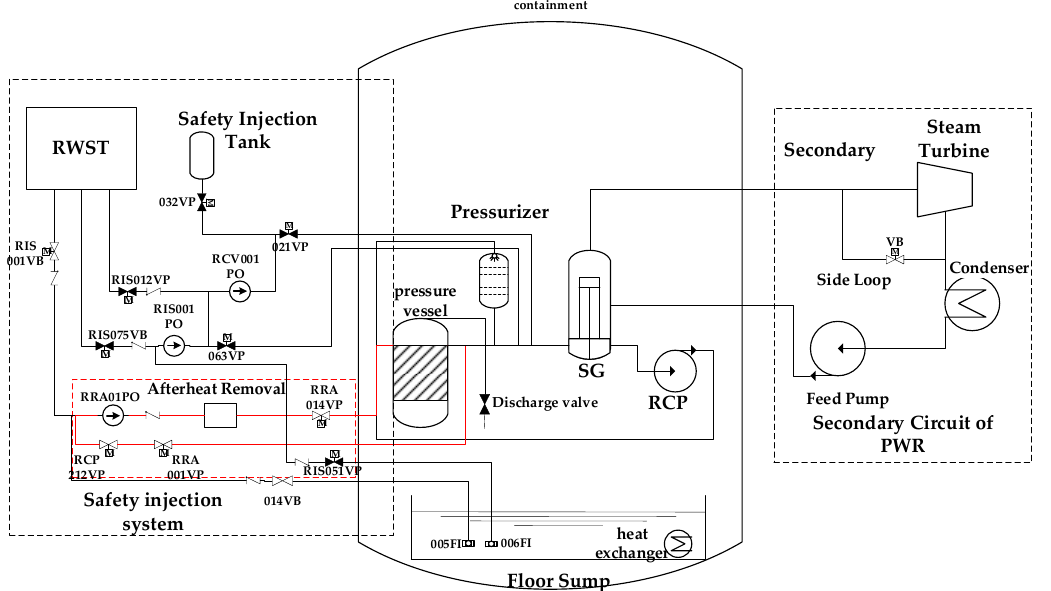
Figure 6. The structure of RHRS and the associated system of a PWR. The red part in the Figure 6 represents the failed of RHR system. Table 1. Description of the equipment in Figure 6.